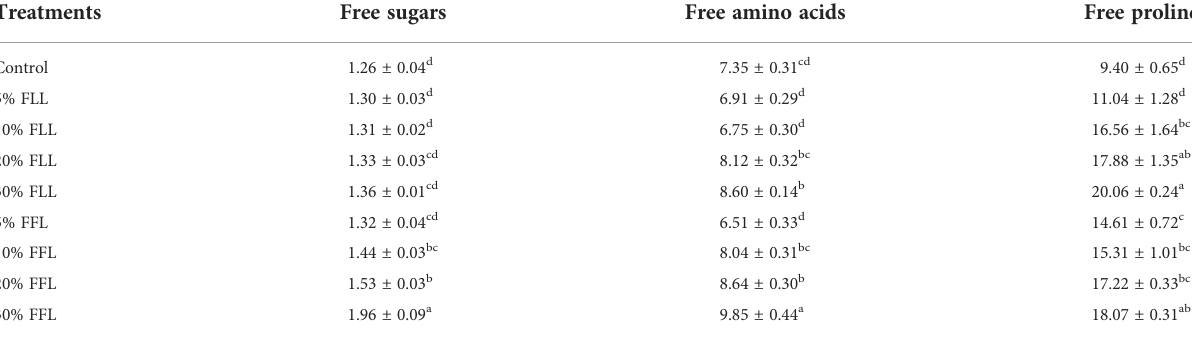
TABLE 5 Free sugars, free amino acids (mg g -1 fr wt), and free proline ( m mole g -1 fr wt) contents in leaves of Triticum aestivum L. plants raised using sand substrate (25 DAS) treated with leachates of fresh leaves and fl owers of Tagetes erecta L. Treatments